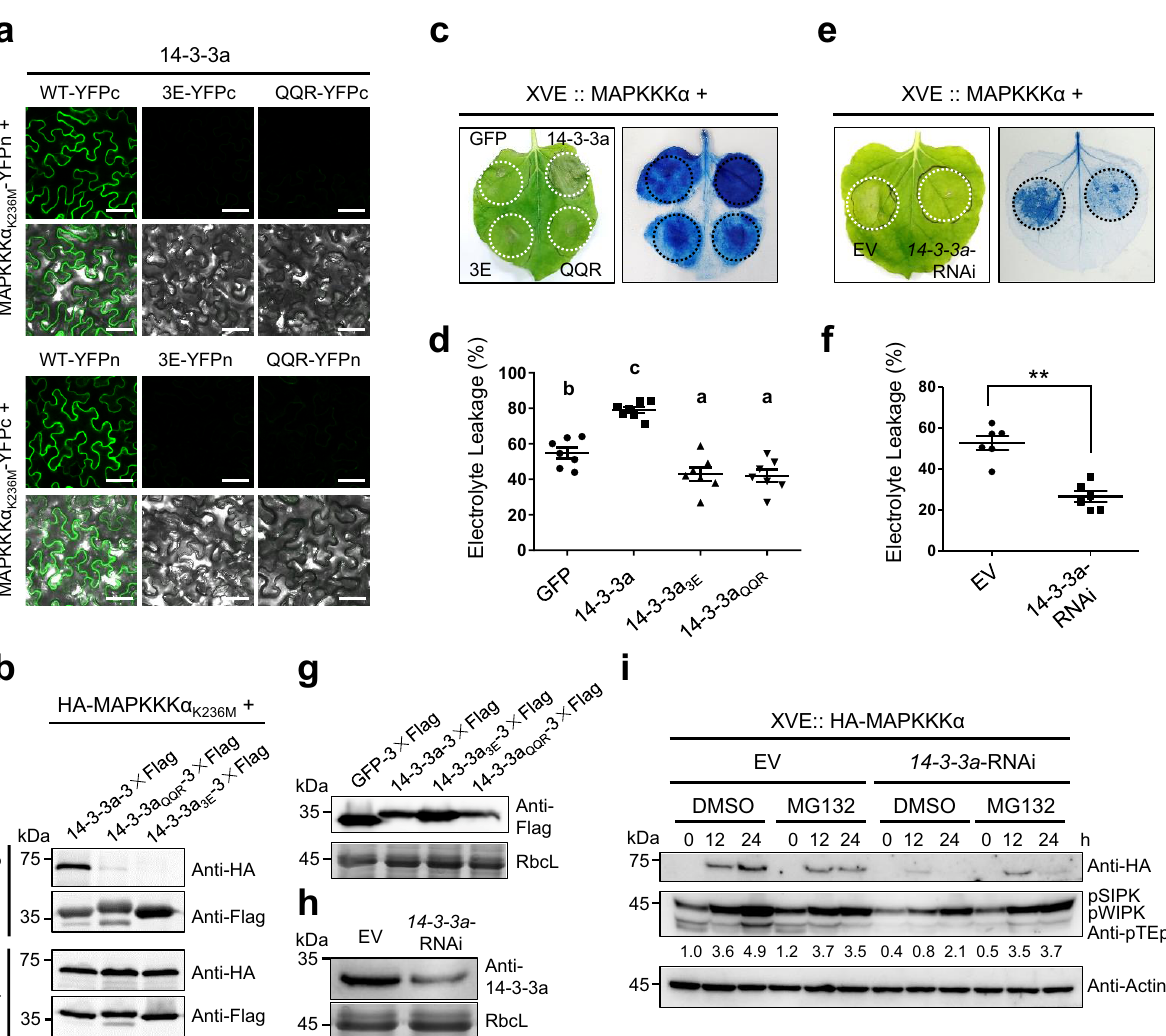
Fig. 4 14-3-3a positively regulates MAPKKK α -induced cell death. a BiFC analysis of the interaction between wild-type or mutant 14-3-3a and MAPKKK α . Combinations of different proteins were transiently expressed in N. benthamiana leaves. Confocal analysis was performed at 3 dpi. Representative results of at least three independent experiments are shown. Scale bars = 50 µ m. b Co-IP analysis of the interaction between wild-type or mutant 14-3-3a and MAPKKK α K236M . N. benthamiana leaves transiently expressing combination of different proteins were harvested at 3 dpi. Total proteins were immunoprecipitated with anti-Flag beads and detected by western blot with an anti-HA or anti-Flag antibody. The experiment was repeated three